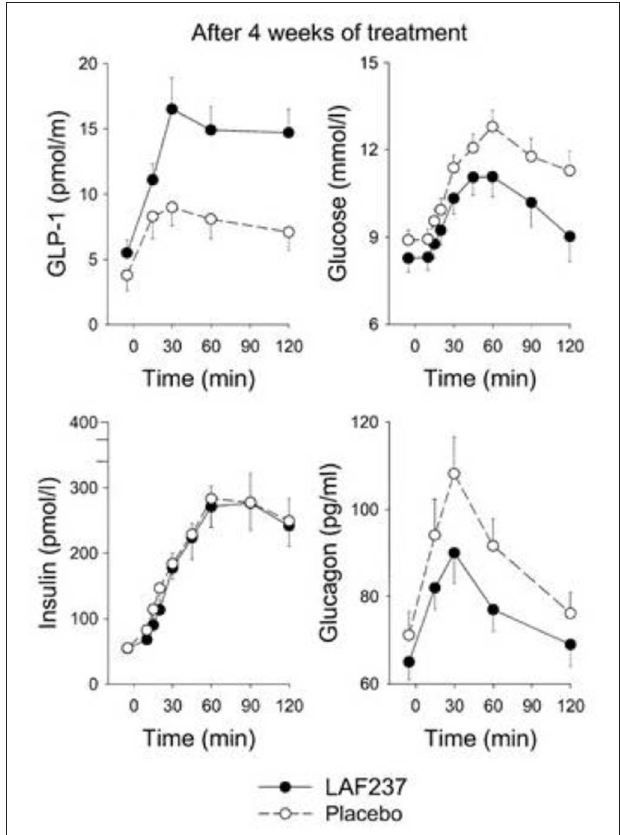
FIGURE 4 | Intact (active) GLP-1, glucose, insulin, and glucagon levels after intake of breakfast (performed at time 0) after 4 weeks of treatment with placebo ( n = 19) or the DPP-4 inhibitor vildagliptin (LAF237) at 100mg daily ( n = 18) in drug-naïve subjects with type 2 diabetes. Means ± sem are shown. Data from Ahrén et al. ( 52). Reprinted with permission from the American Diabetes Association.